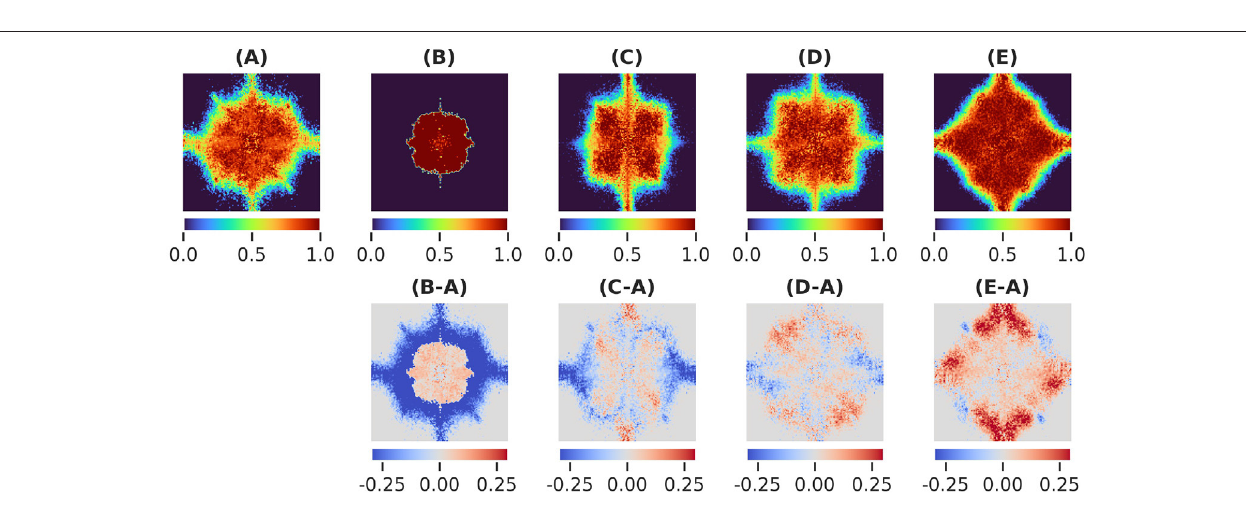
FIGURE 3 | (A) Learned masks for the vanilla network M N , (B) Adversarially trained network M A , (C) scale-invariant network M S , (D) translation-invariant network M T , (E) rotation-invariant network M R and their differences.